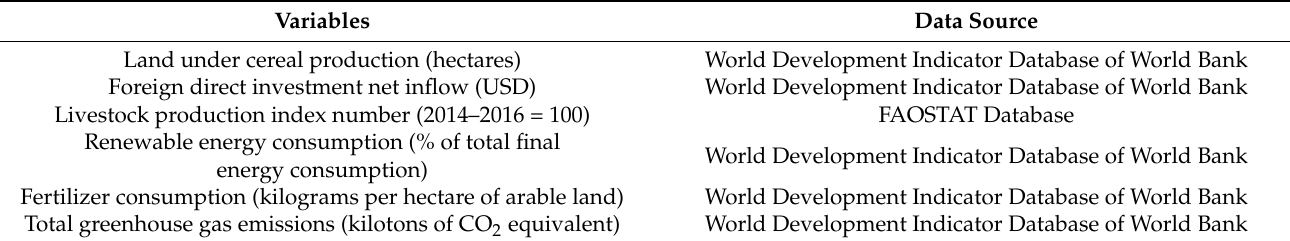
Table 2. Description of the